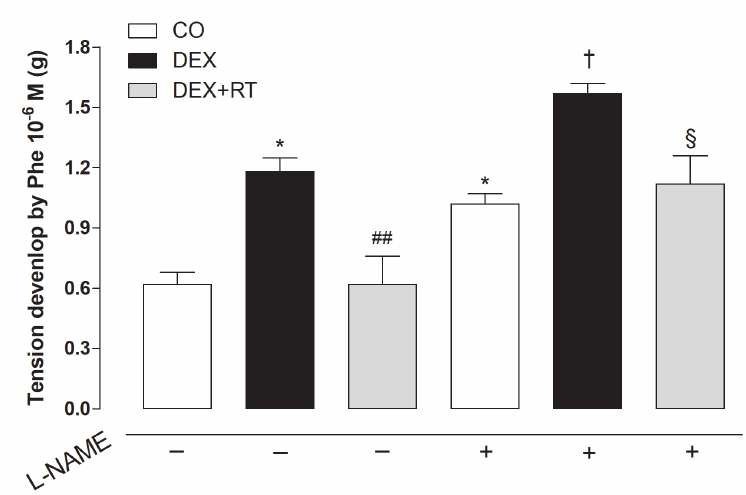
Figure 5. The developed tension elicited by Phe (10 -6 M) was evaluated in mesenteric artery of control (CO), dexamethasone-treated (DEX) and dexamethasone + resistance training (DEX+RT) groups, in the absence or presence of L-NAME (100 μM). The results are expressed as the mean ± SEM for 8–10 experiments in each group. *p < 0.05 vs CO; # p< 0.05 without L-NAME; ## p< 0.01 vs DEX without L-NAME; †p < 0.05, vs. CO with L-NAME; § p< 0.05 vs DEX with